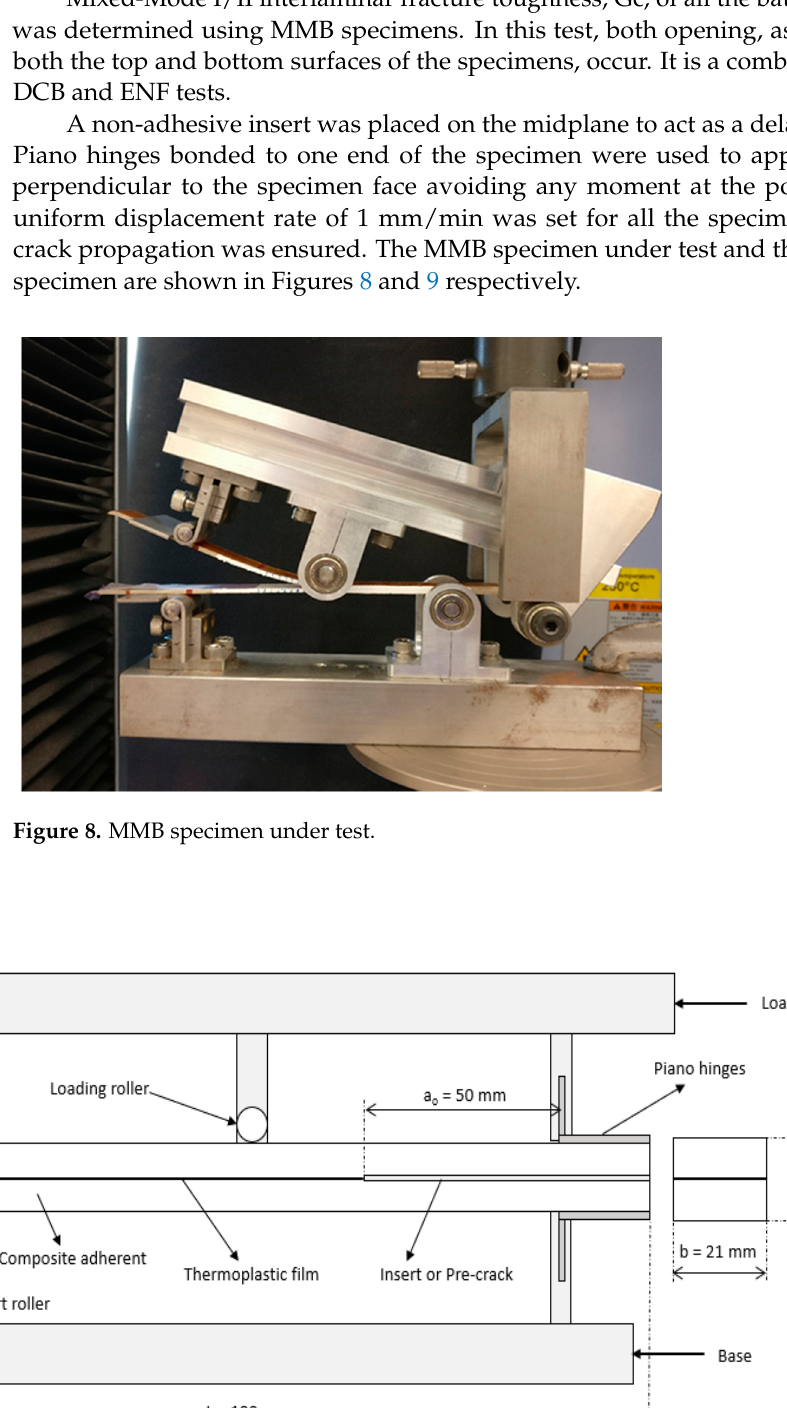
Figure 7. ENF specimen under test.